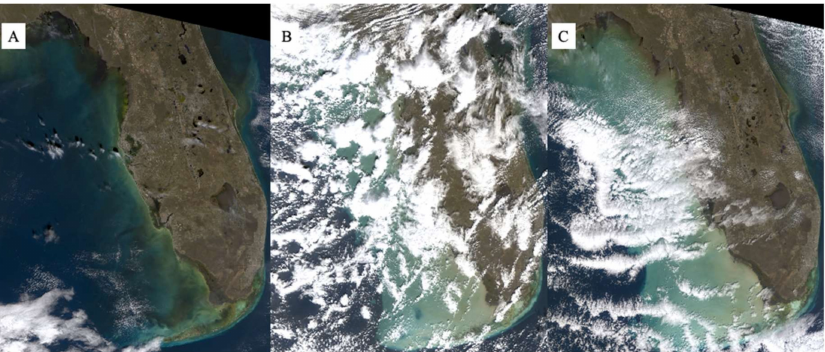
Figure 3. TC fields for the West Florida Shelf (WFS) from the Ocean and Land Colour Imager (OLCI) sensor for ( A ) Sentinel 3A on 18 December, this date was selected as a reference for conditions before the cold-air outbreak (CAO) event; ( B ) Sentinel 3B on 21 December, this is the beginning of the CAO event; and ( C ) Sentinel 3A on 22 December, as the CAO event proceeds. The satellite platform (Sentinel A or B) was selected based on the best spatial coverage for the WFS on that date.